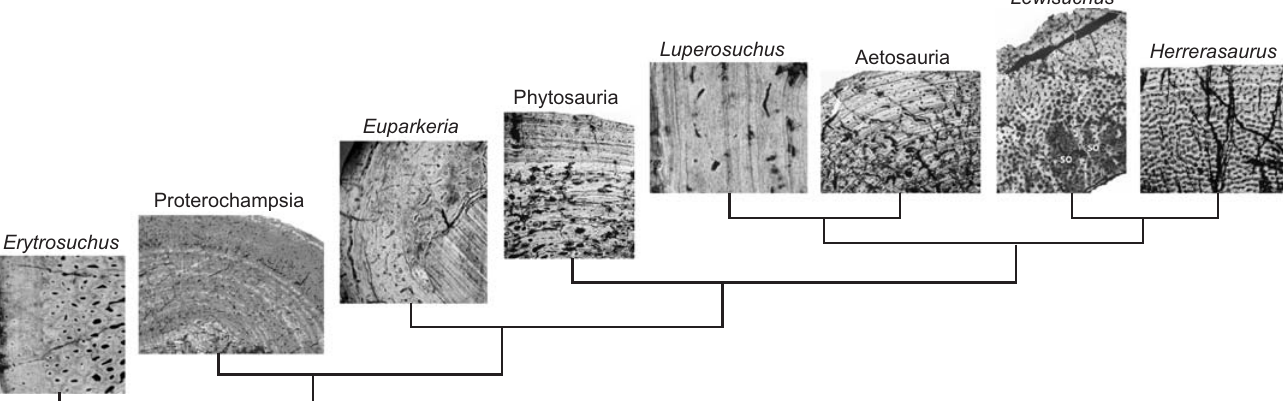
Fig. 7. Phylogenetic interrelationships of Proterochampsia and other archosauriforms showing the histological features in different taxa. Erytrosuchus rib; proterochampsids femur; Euparkeria humerus, Phytosauria femur; Luperosuchus large long bone; Aetosauria humerus; Lewisuchus tibia; Herrerasaurus tibia (modified from Ricqlès et al. 2003, 2008; Garcia Marsà et al.